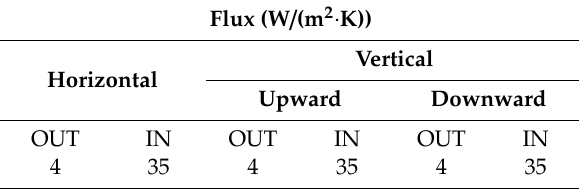
Table 3. Film coe ffi cients used in the Table 3. Film coefficients used in the calculations.